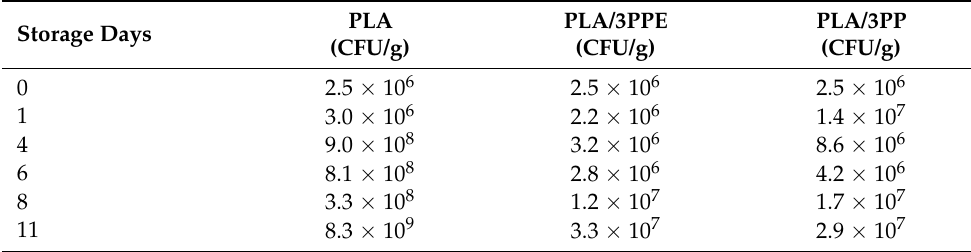
Table 9. Results of the total microorganism count regarding the meat packaged with the control (PLA) and the active (PLA/3PPE and PLA/3PP) films.